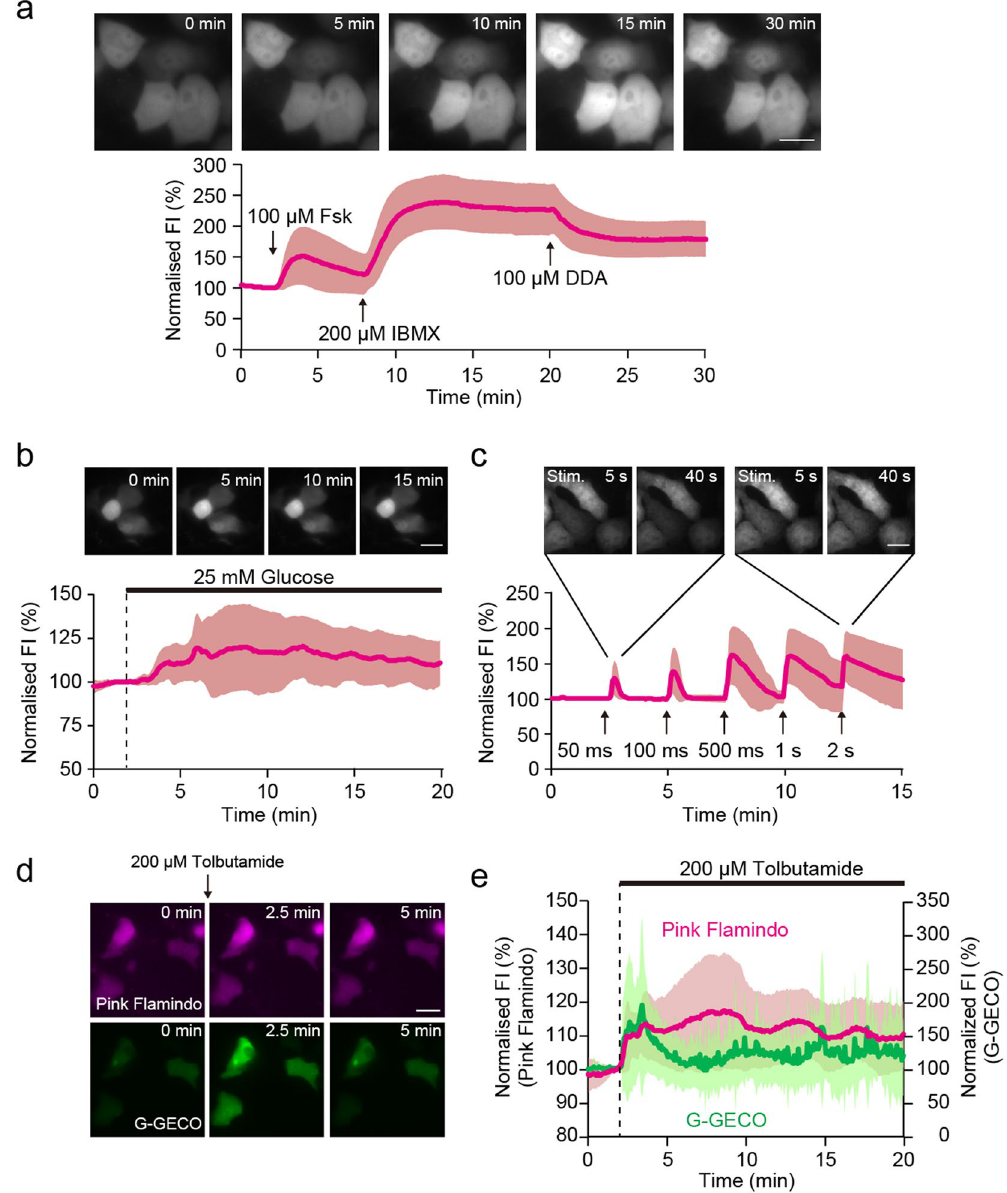
Figure 3. Live cell imaging using Pink Flamindo with photoactivated adenylyl cyclase, and dual-colour imaging with G-GECO. ( a ) Sequential images and time course of fluorescence intensity of Pink Flamindo expressed in HeLa cells after consecutive exposure to 100 μ M Fsk, 200 μ M IBMX and 100 μ M DDA. Scale bar represents 20 μ m. The data represent the means ± standard deviation (n = 30 cells from 5 experiments). ( b ) Sequential images and time course of fluorescence intensity of MIN6 m9 cells expressing Pink Flamindo during the application of 25 mM glucose. Scale bar represents 20 μ m. The data represent the means ± standard deviation (n = 15 cells from 4 experiments). ( c ) Sequential images and time course of fluorescence intensity of HeLa cells co-overexpressing Pink Flamindo and photoactivated adenylyl cyclase (bPAC) upon blue light laser excitation at 1.8 μ W. Scale bar represents 20 μ m. The data represent the mean ± standard deviation (n = 23 cells from 4 experiments). ( d ) Sequential images of MIN6 m9 cells co-overexpressing Pink Flamindo and G-GECO after consecutive exposure to 200 μ M tolbutamide. Scale bar represents 20 μ m. ( e ) Time course of fluorescence intensity of MIN6 m9 cells co-overexpressing Pink Flamindo and G-GECO. The data represent means ± standard deviation (n = 18 cells from 4